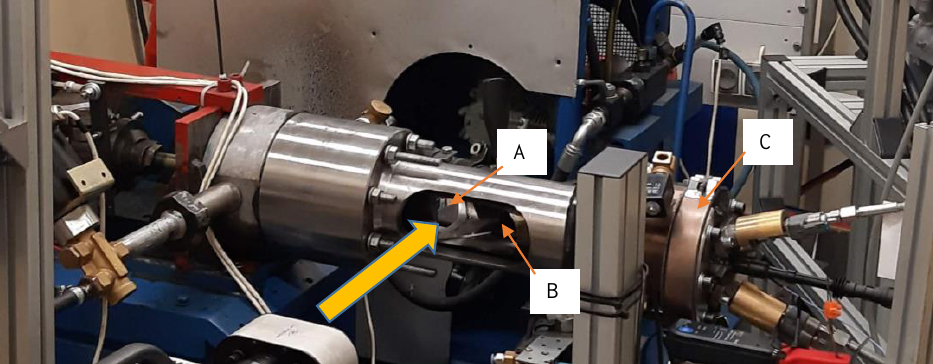
Figure 3. Rapid compression machine: ( A ) mirror directing the image from under the piston to the recording camera; ( B ) piston; ( C ) engine head. Table 4. Technical data for the rapid compression machine used for the combustion